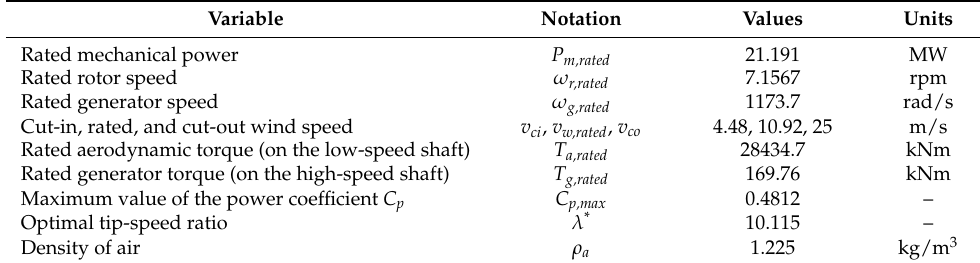
Table 2. Rated values for the 20 MW wind turbine.